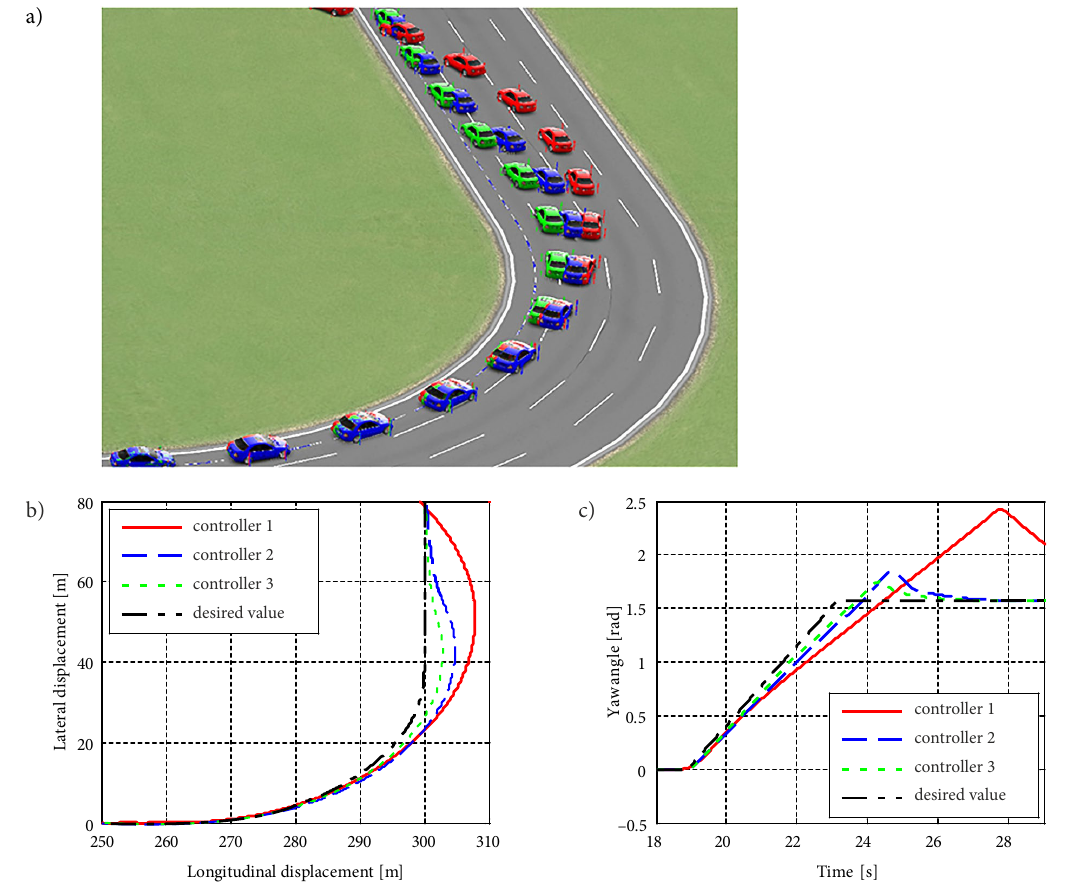
Figure 6. Simulation results in the anti-sideslip simulation: a – animation effect; b – lateral displacement; c – yaw